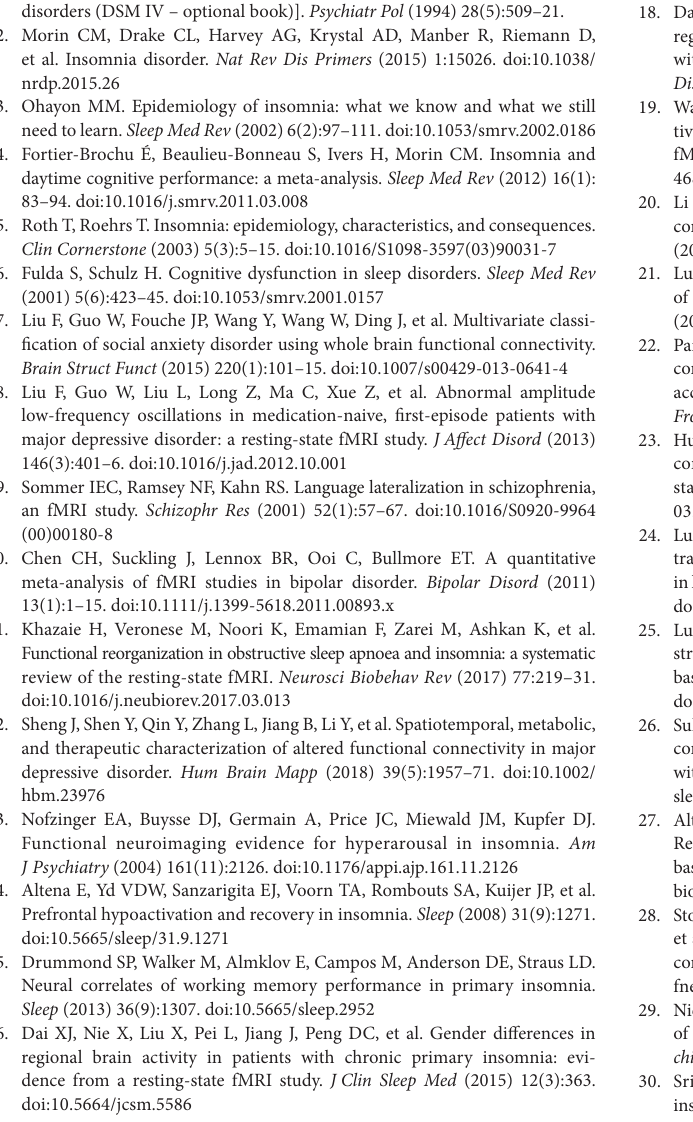
FigUre s6 | The effective connectivity from the whole brain to ventral right anterior insula. FigUre s7 | The effective connectivity from the whole brain to dorsal right anterior insula. FigUre s8 | The statistical results of the permutation threshold-free cluster enhancement correction (5,000 times permutation, default parameters, FWE corrected, P < 0.05). (a) Between-group differences in effective connectivity from ventral right anterior insula (rAI) to the whole brain. (b) Between-group differences in effective connectivity from dorsal rAI to the whole brain. (c) Between-group differences in effective connectivity from the whole brain to ventral right anterior insula. FigUre s9 | Relationships between effective connectivity and sleep and emotion scales in healthy control group. FigUre s10 | Temporal-domain bold signals for seed